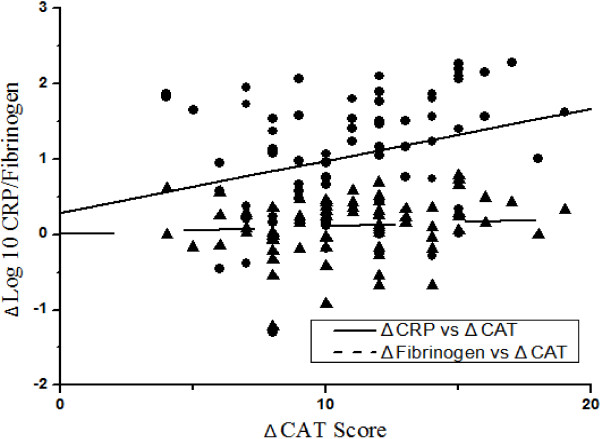
Pearson correlations between the change in CAT score and the changes of inflammatory biomarkers. ● solid line = Δ㏒10CRP vs ΔCAT: r = 0.286, P < 0.05; ▲ dash line = Δ㏒10 fibrinogen vs ΔCAT: r = 0.137, P > 0.05. Δ = the change of CAT scores and the concentrations of CRP and fibrinogen.